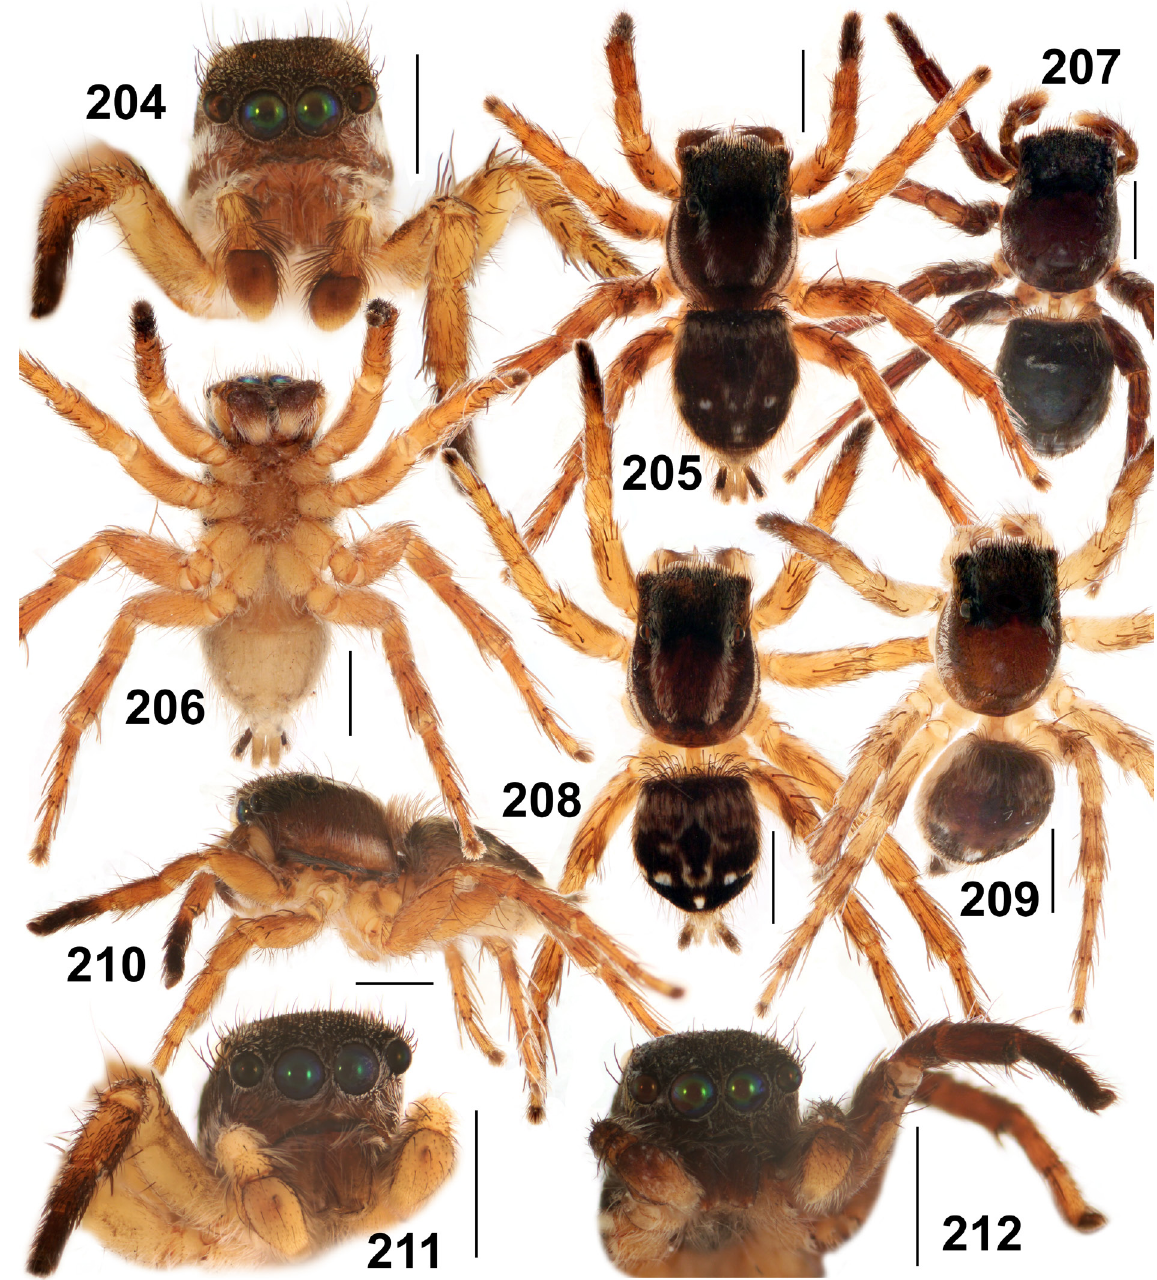
Figs 204–212. Stenaelurillus guttiger (Simon, 1901), ♂♂, general appearance . Specimens: 204–206, 208, 210 paratype of S . natalensis Haddad & Wesołowska, 2006 from South Africa ( Ndumo GR; NCA 2006/678); 207, 209, 211–212 from South Africa (Polokwane GR; NCA 2008/2067). Scale bars: 1